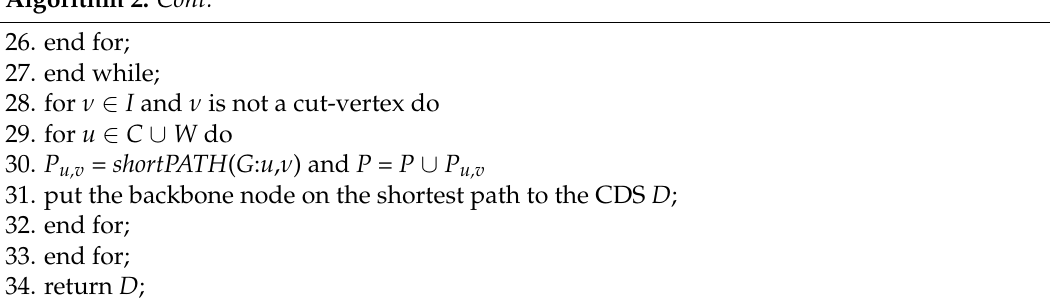
( b ) Figure 7. The distribution and coverage of active nodes after sleep scheduling. ( a ) Dormant nodes’ deployment; ( b ) Coverage area . With the gradual depletion of the energy of some nodes, Figure 8 shows the situation while some active nodes failed in the network, where “x” indicates the failed node. During the current round, there are five active nodes being labeled failed state due to energy depletion, and the network can no longer be able to achieve full coverage of the region.